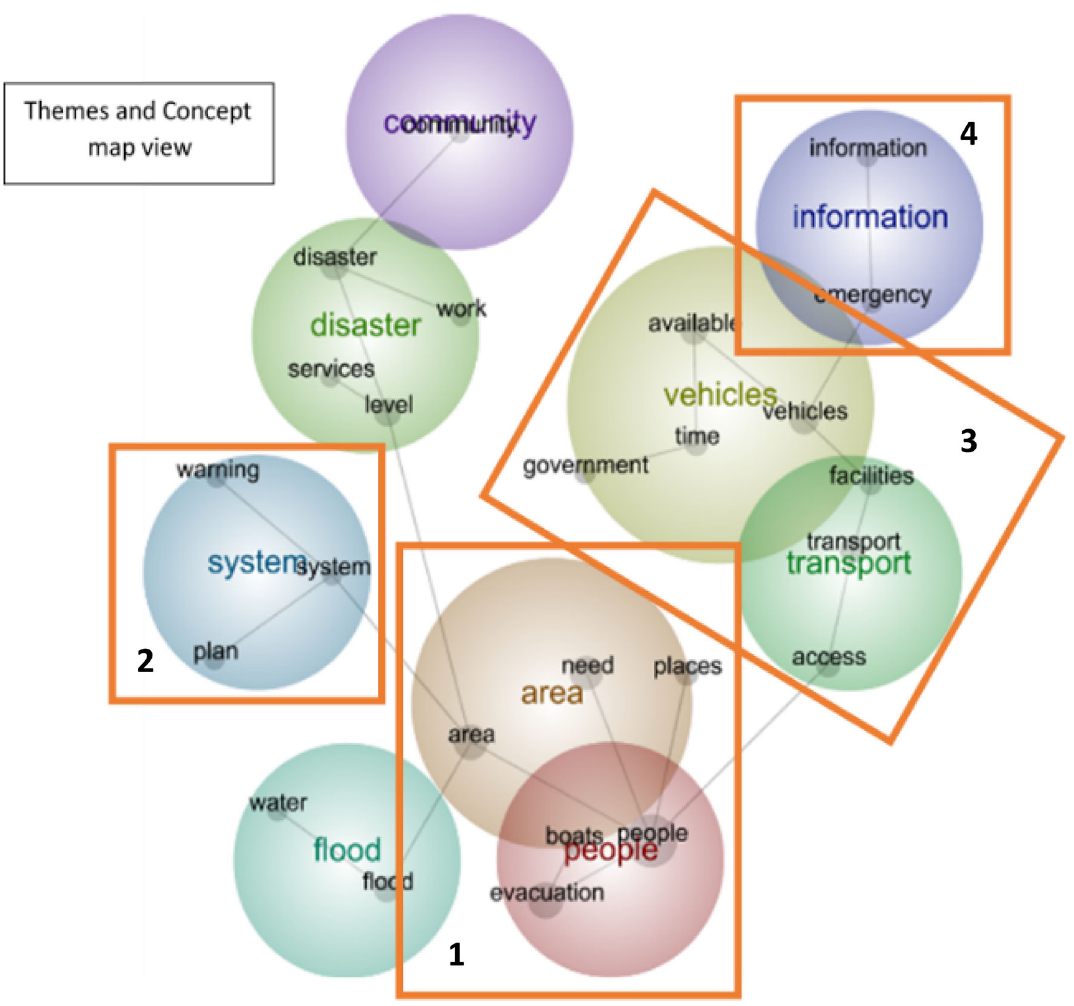
Fig. 8 Original Leximancer concept/theme map view from interview data of case study location #4, Ampara District/Eastern Province (Subnational Level), Sri Lanka. Concepts (shown as nodes and in